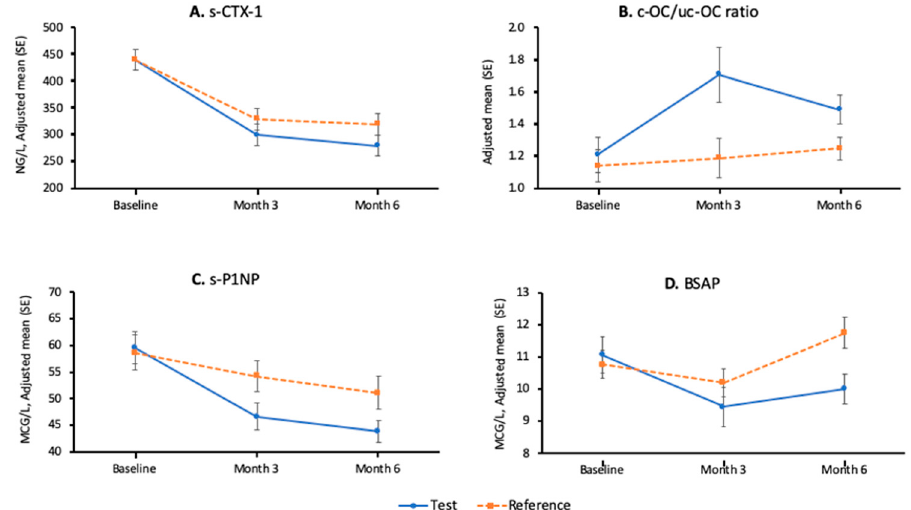
Figure 2. Adjusted mean ( ± standard error) plots by time and treatment (intent-to-treat (ITT)) population: n = 102. ( A ): s-CTX-1; ( B ): c-OC/uc-OC ratio; ( C ): s-PINP; ( D ): BSAP . Table 5. Changes in bone metabolism parameters (secondary endpoints) in response to test and control products over six months.